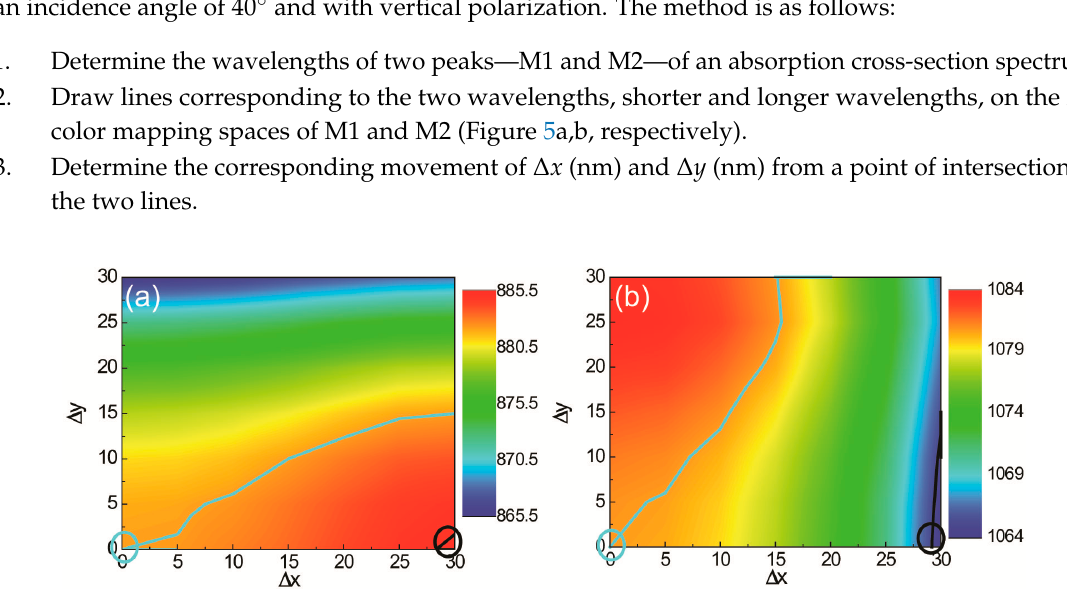
Figure 5. 2D color mapping of the absorption cross-section peak wavelengths of ( a ) mode 1 (M1) and ( b ) mode 2 (M2) as functions of Δ x (nm) and Δ y (nm). Cyan lines in (a) M1 and (b) M2 indicate resonant wavelengths—882.2 and 1081.3 nm—for the movement of Δ x = 0 nm, Δ y = 0 nm. Black lines indicate 885.1 and 1064.7 nm for the movement of Δ x = 30 nm and Δ y = 0 nm, respectively. The color bar at the right represents the absorption cross-section peak wavelengths.